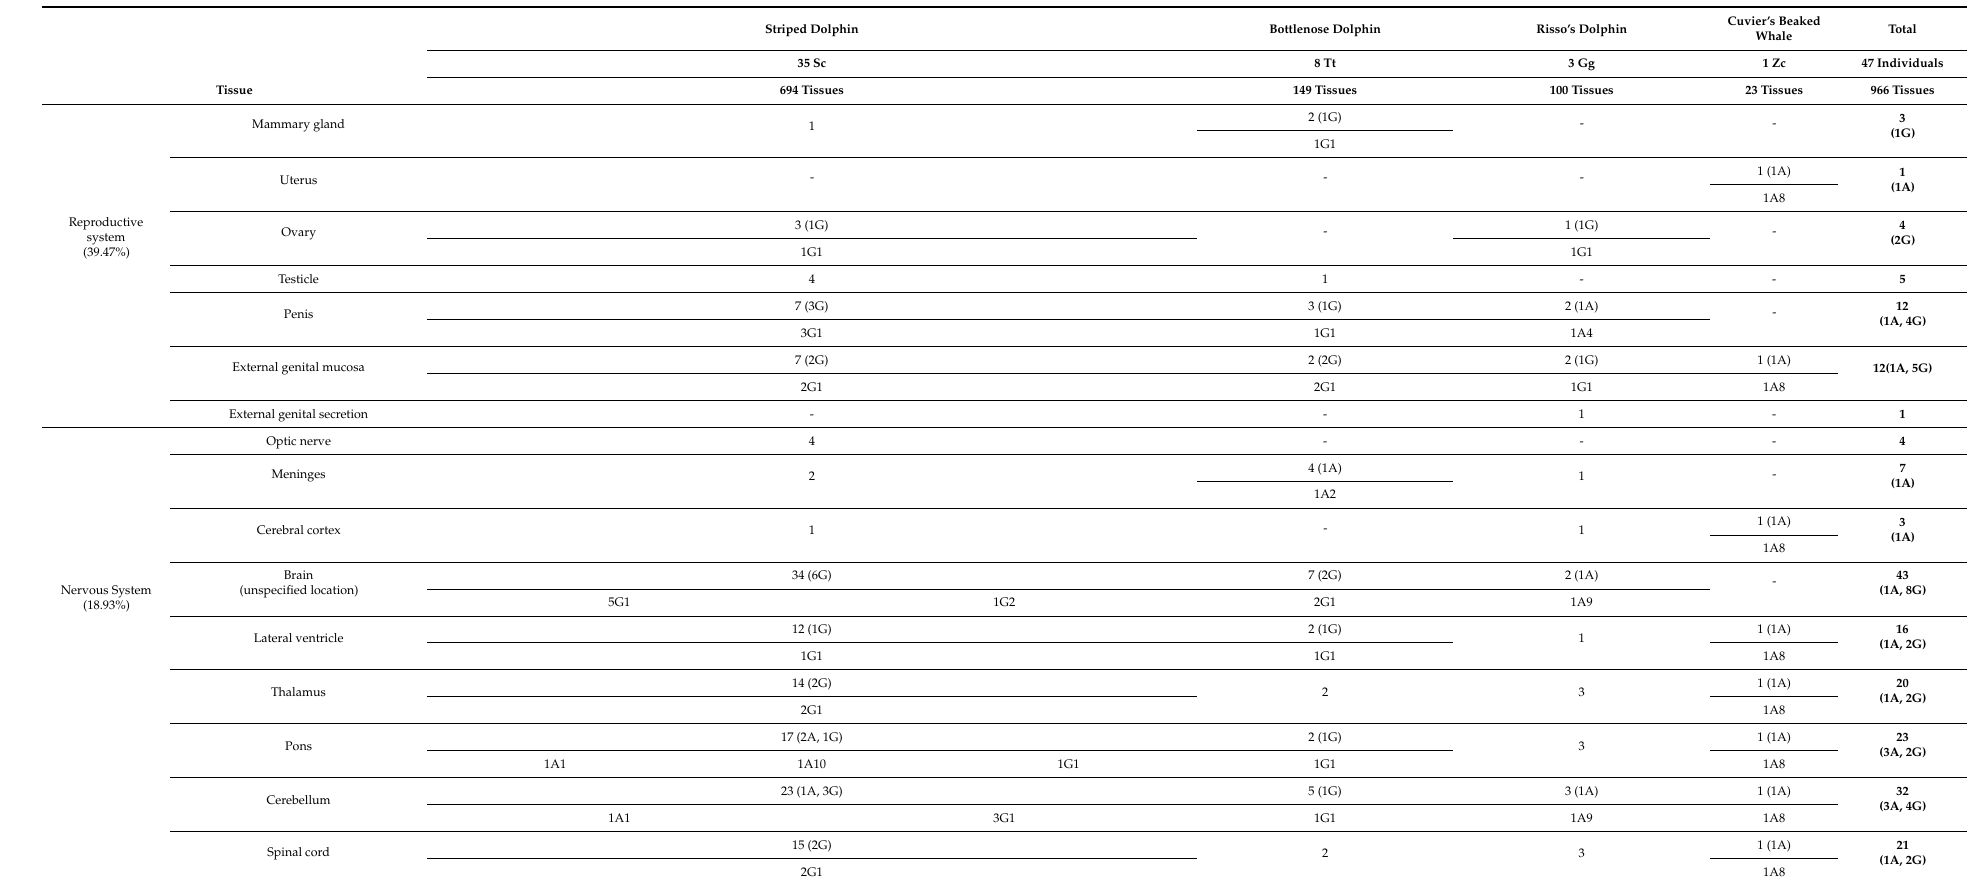
Table 1. HV detection in cetaceans at tissue level, in addition to being stratified by organ system and species. The percentage of positive samples in each organ system is shown below the name of that system in the leftmost column. Numbers not in parentheses refer to how many samples of the specific tissue from the indicated cetacean were analyzed, and numbers in parentheses refer to how many HV sequences were detected. Thus, “7 (2G)” means that two sequences were identified in seven analyzed samples, and that both belonged to Gammaherpesvirinae . The notation “2G1” means that the sequence G1 was detected twice in the given tissue and species. Sc, Stenellacoeruleoalba ; Tt, Tursiops truncatus ; Gg, Grampus griseus ; Zc, Ziphius cavirostris . The bold parts refer to the total of individuals studied, tissues analyzed and types of sequences